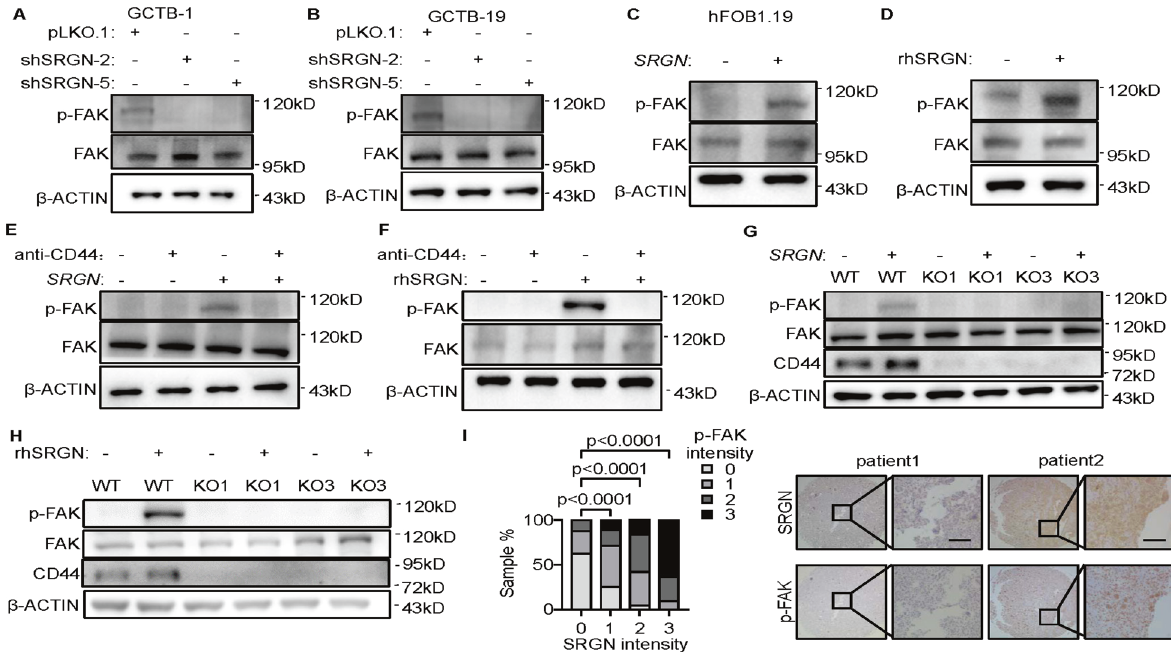
Fig. 5 SRGN activates focal adhesion kinase through CD44. A − D Western blot analysis of phosphorylated FAK protein level in RAW264.7 cells after treatment with CM from GCTB-1 ( A ) or GCTB-19 ( B ) with SRGN knockdown, CM from hFOB1.19 with SRGN overexpression ( C ), or human recombinant SRGN protein ( D ). E Western blotting analysis of phosphorylated FAK protein level in RAW264.7 cells after treatment with CM from hFOB1.19 with SRGN overexpression and the CD44 neutralizing antibody. F Western blotting analysis of phosphorylated FAK in RAW264.7 cells after treatment with human recombinant SRGN protein and the CD44 neutralizing antibody. G , H Western blotting analysis of phosphorylated FAK in RAW264.7 CD44 -knockout cells after treatment with CM from hFOB1.19 with SRGN overexpression ( G ) and human recombinant SRGN protein ( H ). I FAK phosphorylation levels in human GCTB samples with different levels of SRGN expression. Protein expression was scored as 0 (negative), 1 (weak), 2 (moderate) and 3 (strong) by immunohistochemistry staining ( n = 71 patients). Scale bar, 100 μ m. P values were obtained by chi-squared test ( I